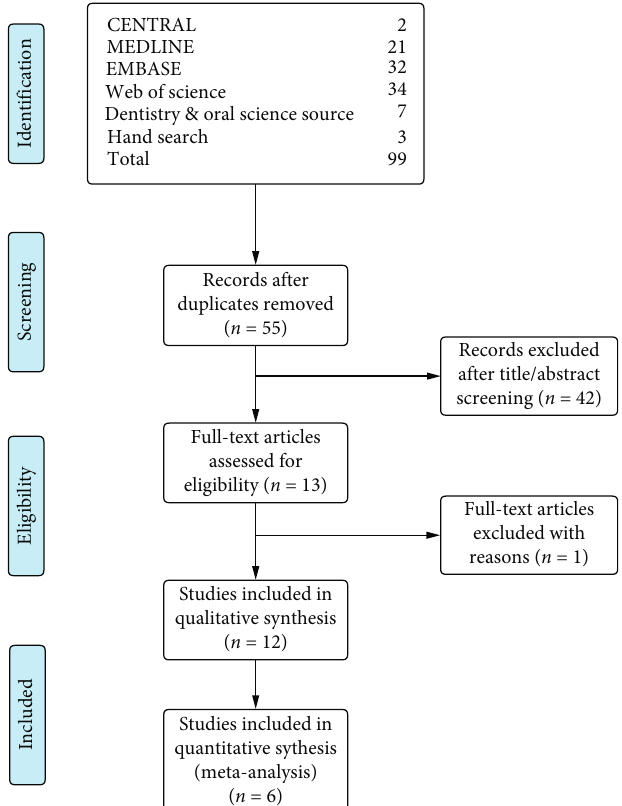
Figure 1: Flow chart of study screening and selection process (following PRISMA guidelines). Nighty-eight studies were retrieved from fi ve databases and hand search, and fi fty-four studies were left after the removal of duplicates. Twelve studies were included in qualitative analysis, and six studies were included in quantitative studies after title/abstract and full-text